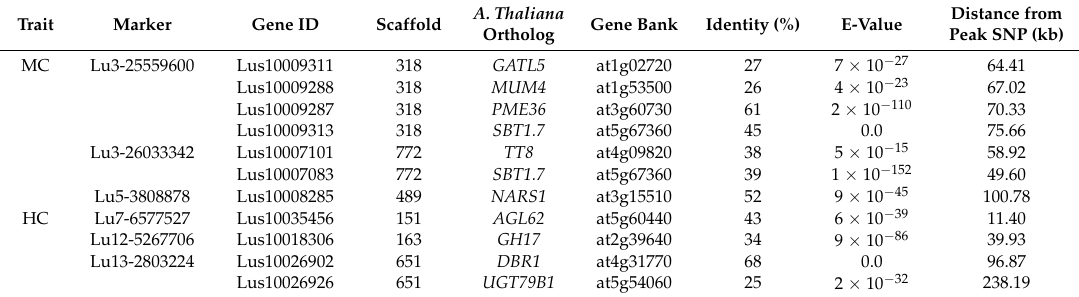
Table 2. Candidate genes within LD blocks harboring peak SNPs associated with MC and